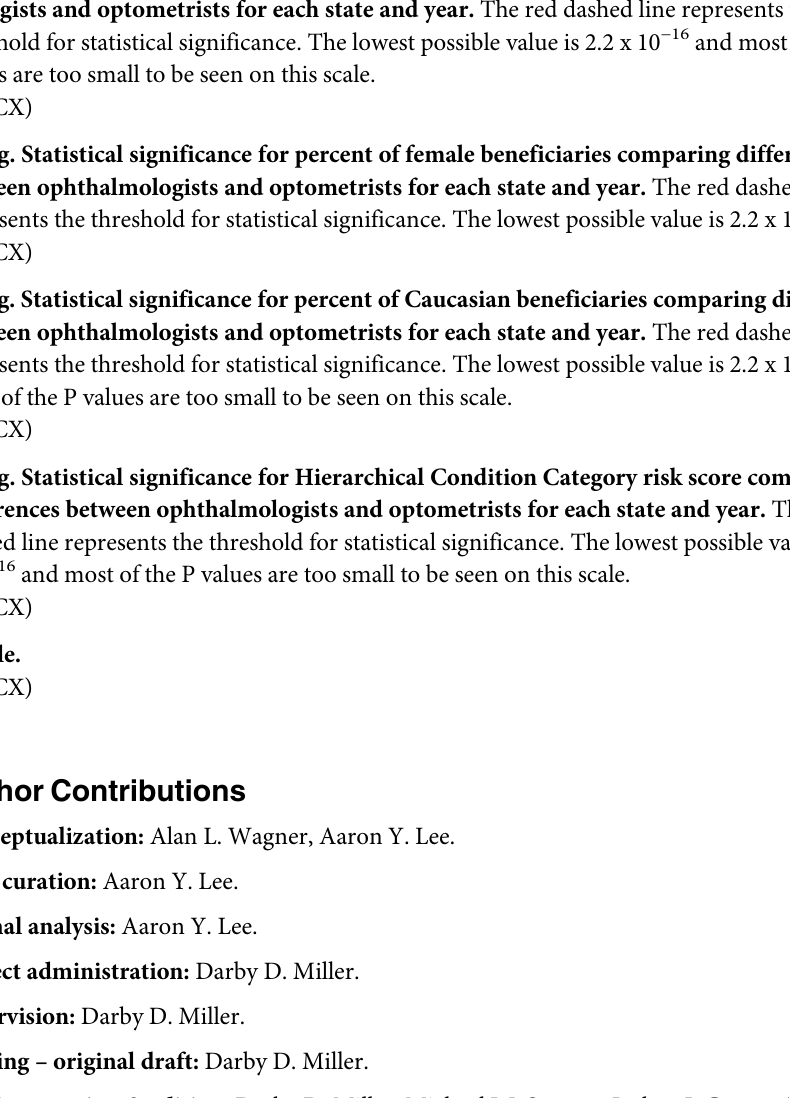
S1 Fig. Statistical significance test for average age comparing differences between ophthal- mologists and optometrists for each state and year. The red dashed line represents the threshold for statistical significance. The lowest possible value is 2.2 x 10 − 16 and most of the P values are too small to be seen on this scale. S2 Fig. Statistical significance for percent of female beneficiaries comparing differences between ophthalmologists and optometrists for each state and year. The red dashed line represents the threshold for statistical significance. The lowest possible value is 2.2 x 10 − 16 . S3 Fig. Statistical significance for percent of Caucasian beneficiaries comparing differences between ophthalmologists and optometrists for each state and year. The red dashed line represents the threshold for statistical significance. The lowest possible value is 2.2 x 10 − 16 and most of the P values are too small to be seen on this scale. S4 Fig. Statistical significance for Hierarchical Condition Category risk score comparing differences between ophthalmologists and optometrists for each state and year. The red dashed line represents the threshold for statistical significance. The lowest possible value is 2.2 x 10 − 16 and most of the P values are too small to be seen on this